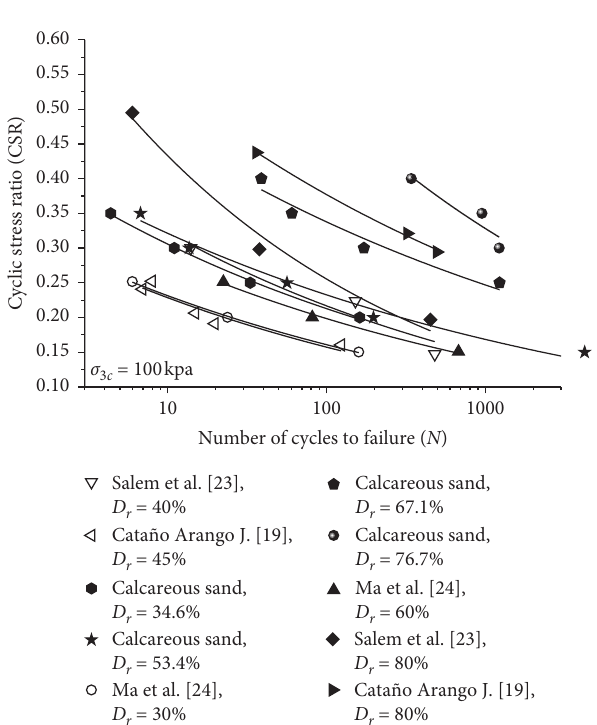
Figure 11: Comparison of the cyclic strength of different types of calcareous sand [19, 23,